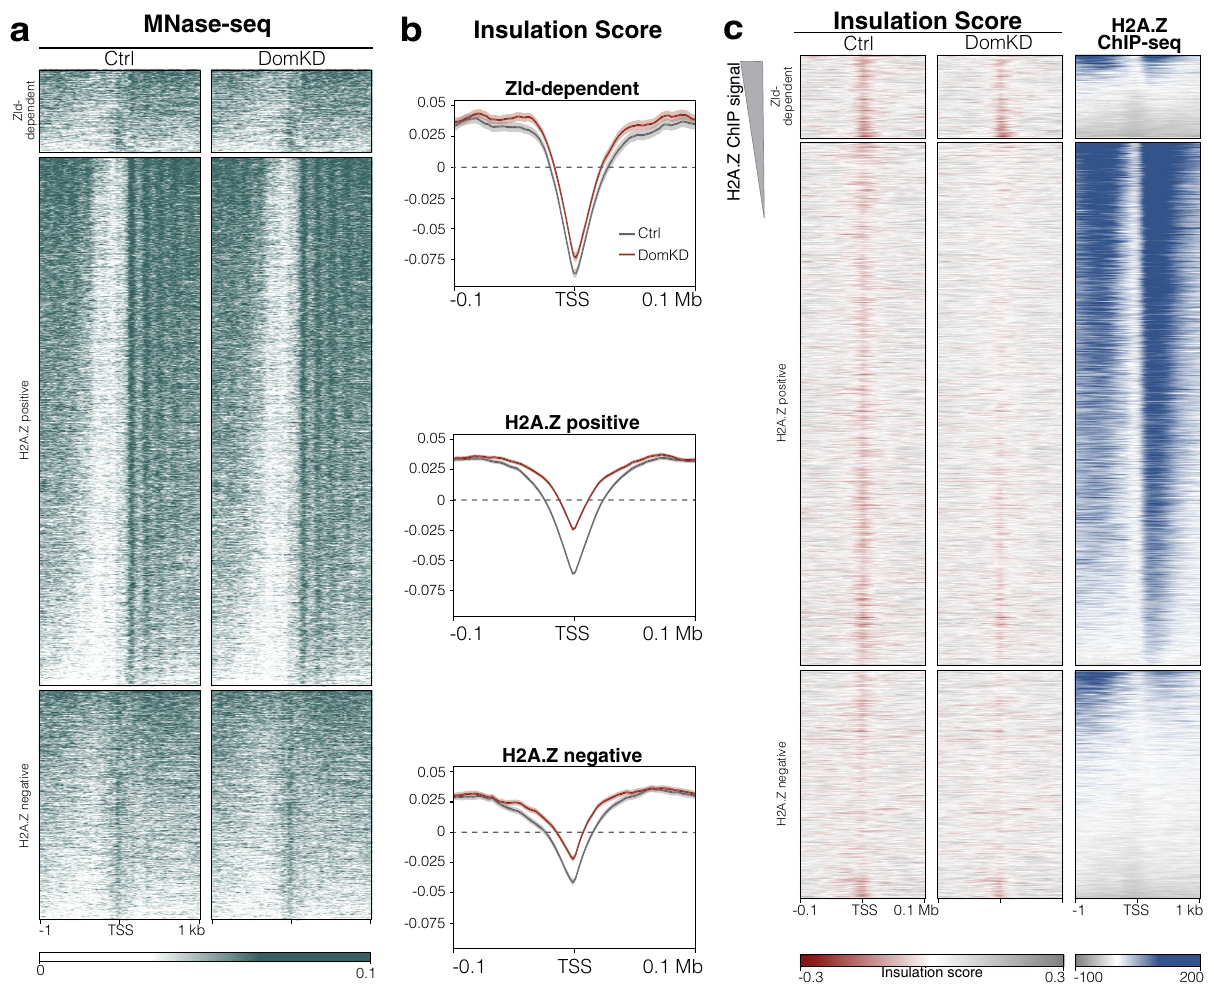
Fig. 4 Domino is required for the correct establishment of TADs insulation but not for nucleosome positioning. a Heatmap of MNase signal in Ctrl and DomKD embryos at ZGA in Zld-dependent, H2A.Z positive and H2A.Z negative promoters. The heatmap is sorted by MNase-seq signal in Ctrl embryos. Tracks show the signal obtained after merging two biological replicates per condition. b Pro fi le plots of insulation score in Zld-dependent, H2A.Z positive and H2A.Z negative promoters comparing Ctrl vs DomKD embryos at ZGA. The center line indicates the median and the semi-transparent lines represent the standard error of a given group and condition, which indicates that in all groups DomKD is signi fi cantly different than the control at TSS. c Heatmap of the insulation score in Ctrl and DomKD embryos sorted by H2A.Z Ctrl signal at ZGA. All tracks are from embryos at